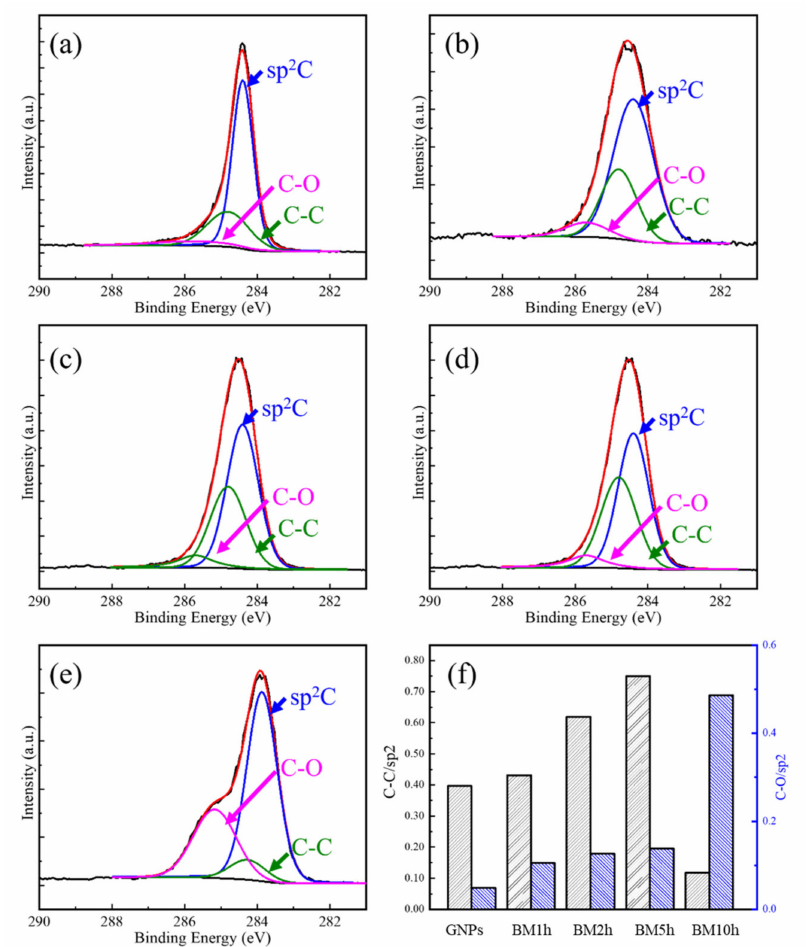
Figure 5. XPS characterization of C1s orbital binding energy of GNPs. ( a ) Initial GNPs, ( b ) BM1h, ( c ) BM2h, ( d ) BM5h, ( e ) BM10h, ( f ) the ratio of the C–C peak area and sp 2 peak area (C–C/sp 2 )